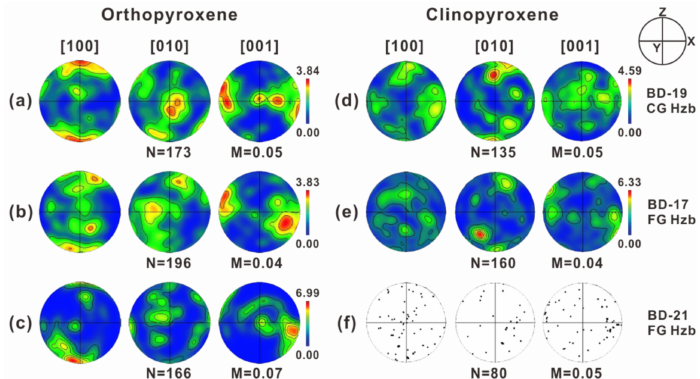
Figure 6. Pole figures showing the lattice preferred orientations (LPOs) of ( a – c ) orthopyroxene and ( d – f ) clinopyroxene from coarse-granular (CG) and fine-granular (FG) harzburgite (Hzb) from the Baekdusan peridotites. The east–west direction corresponds to the stretching lineation (X) and the north–south direction (Z) is normal to the foliation. Color-coding represents the density of data points. Equal-area lower-hemisphere projection was used with a half scattering width of 20 ◦ . N indicates the number of grains measured. Pyroxene fabric (LPO) strength is denoted by M (M-index)